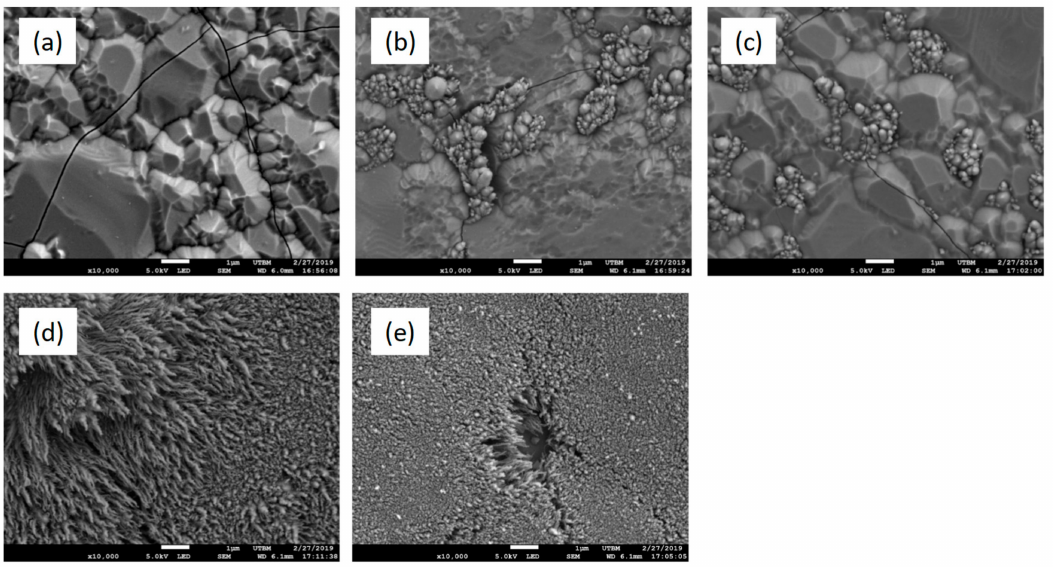
Figure 7. SEM images of the surface morphology of calcined LSACO coatings on alumina substrate: ( a ) LSACO-1, ( b ) LSACO-2, ( c ) LSACO-3, ( d ) LSACO-4, and ( e )